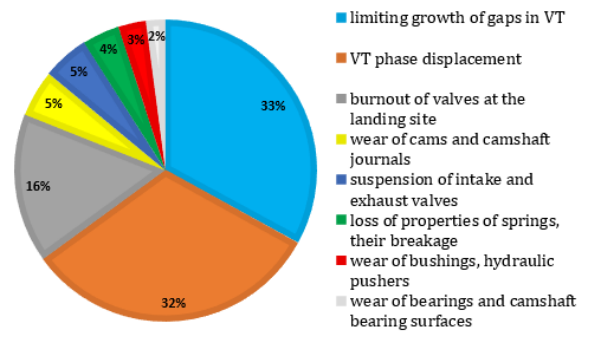
Figure 1. Percentage distribution of VT failures Fig. 1 shows that most failures occur due to the limiting growth of VT and VT phase displacement